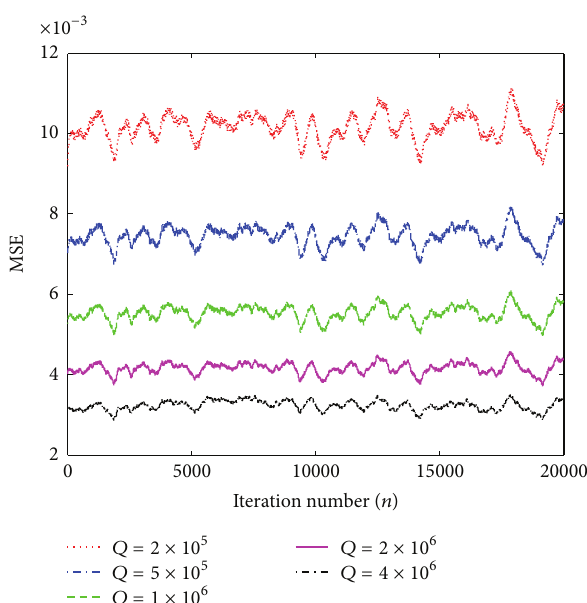
Figure 16: The MSE using the LQG feedback control under different 𝑄 matrix.